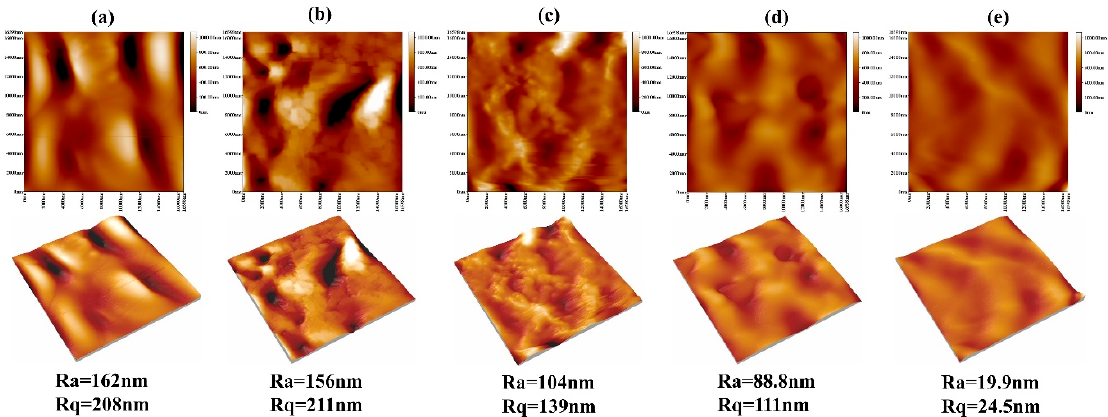
Figure 6. AFM images of MAO-WE43 and GelMA/MAO-WE43 samples. Ra: mean value of roughness; Rq: root mean square of roughness; ( a ): 1#, MAO-WE43; ( b ): 2#, 1GelMA/MAO-WE43; ( c ): 3#, 5GelMA/MAO-WE43; ( d ): 4#, 10GelMA/MAO-WE43; ( e ): 5#, 15GelMA/MAO-WE43.